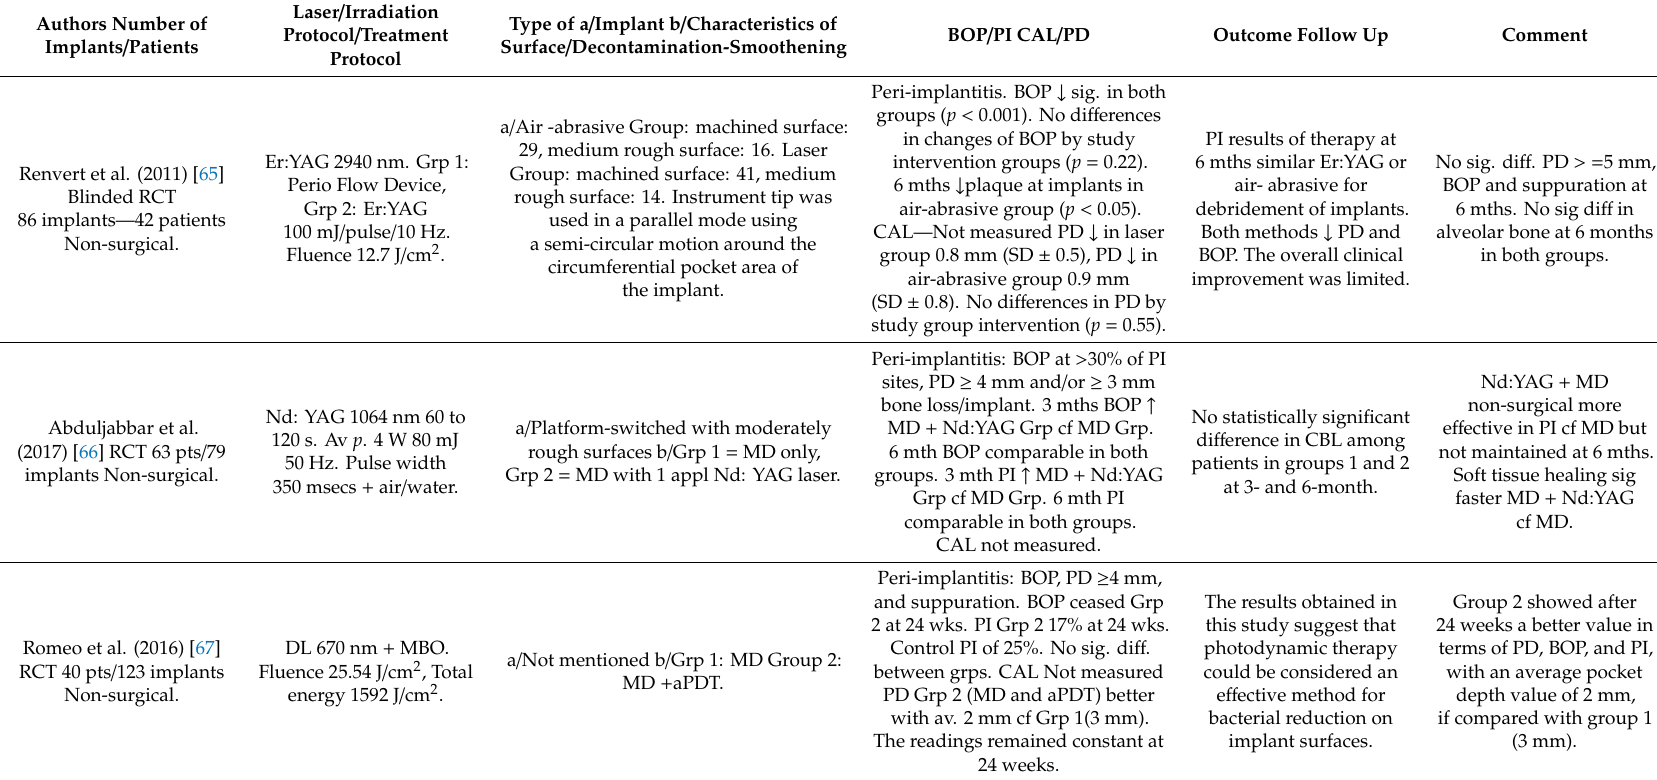
Table 2. Analysis of peri-implantitis, non-surgical